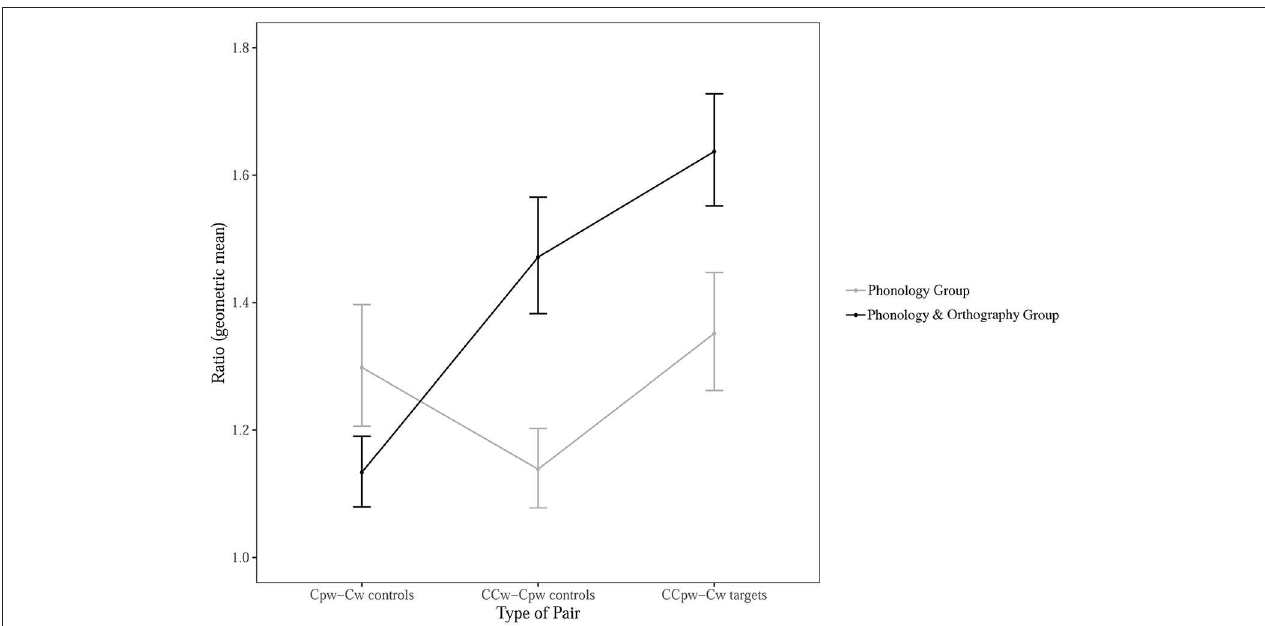
FIGURE 3 | The geometric mean of consonant duration ratio as a function of group (Phonology, Phonology & Orthography) and type of pair (C pw -C w , CC w -C pw , CC pw -C w ). Bars represent 95% CI s.